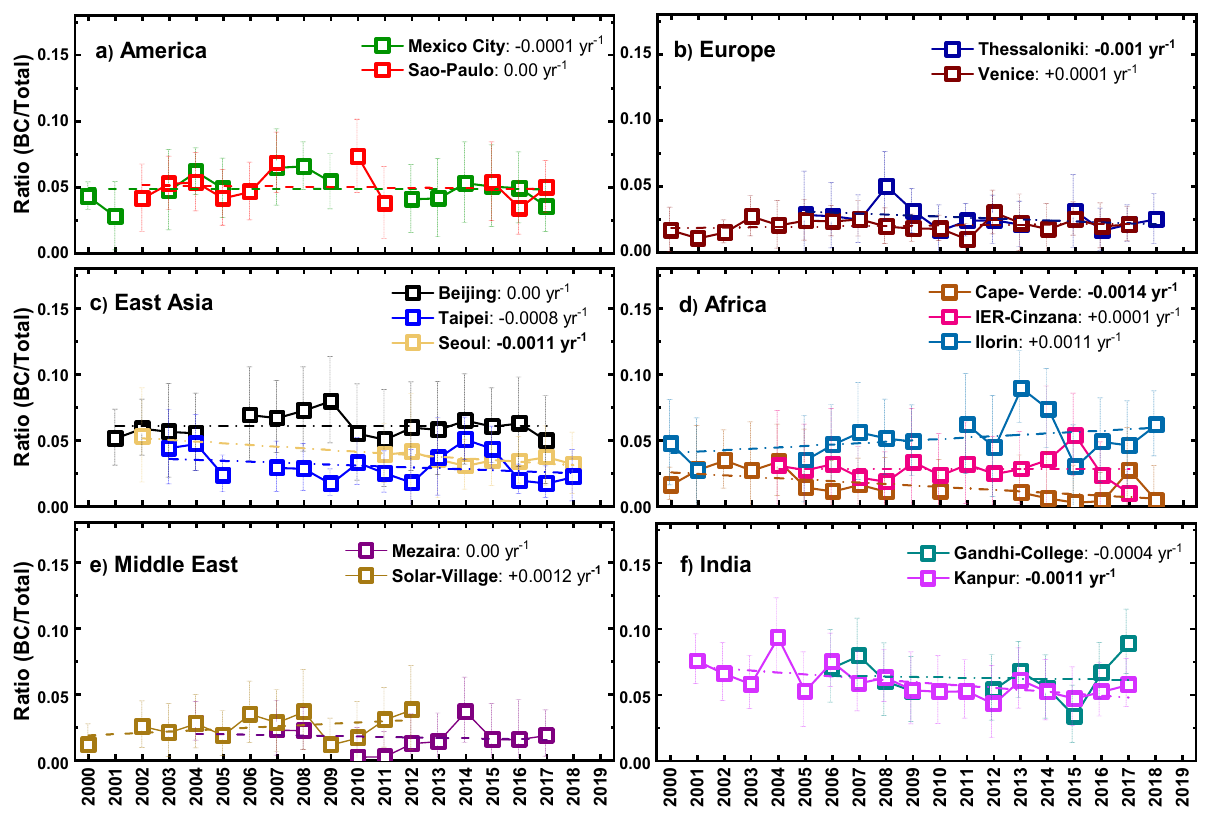
Figure 5. Variations of annual AAOD BC /AOD T ratio at 440 nm from 2000 to 2018 at fourteen sites. Error bars represent the standard deviation of the annual averages (units yr − 1 ).